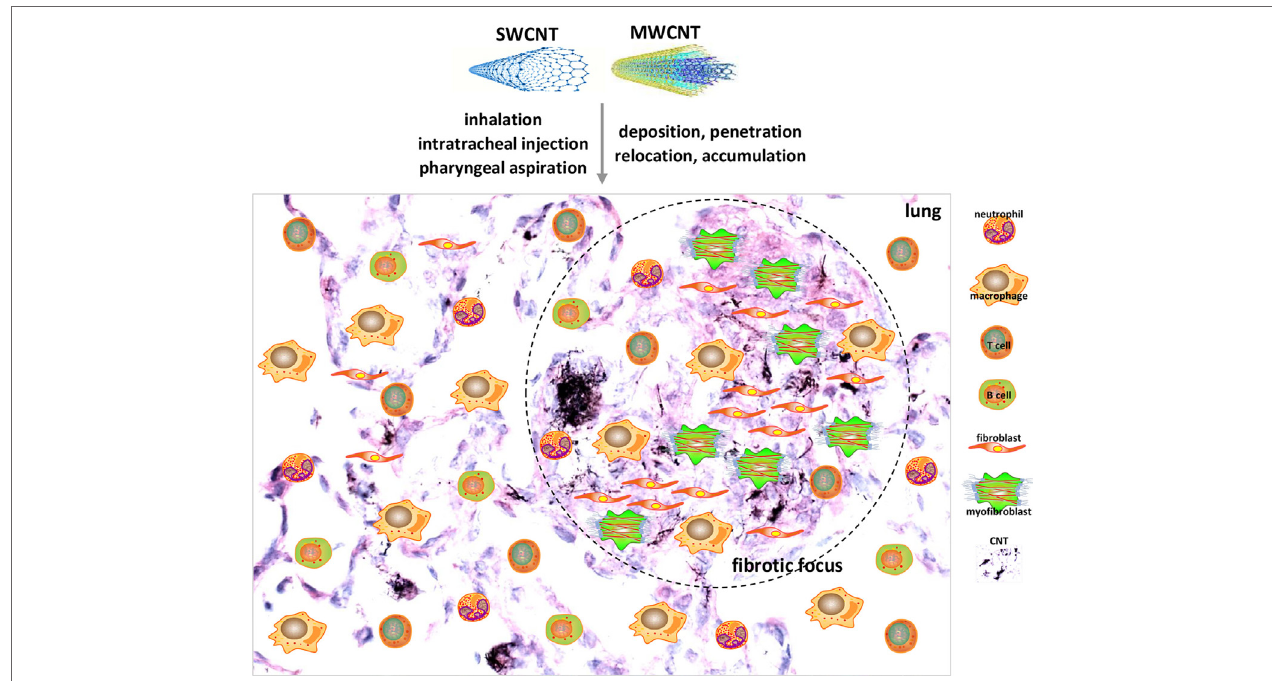
FiGURe 1 | Acute lung inflammation and fibrosis induced by carbon nanotubes (CNTs). CNTs are nano-scaled, respirable fibers with propensity to deposit, penetrate, relocate, and accumulate in lung tissues. Pulmonary exposure to CNTs induces acute-phase responses including a vigorous inflammatory response represented by immune cell recruitment, infiltration, and activation, and a fibrotic response demonstrated by fibroblastic cell accumulation, extracellular matrix deposition, and fibrotic focus formation. Shown are examples of cell types implicated in acute-phase responses as insets on a histopathological image of mouse lungs on day 7 post-exposure to MWCNTs to illustrate acute inflammation and fibrosis. These acute-phase lesions will transit to chronic-phase responses with the occurrence of interstitial fibrosis, epithelioid granuloma formation, and mild inflammation that persist for at least 1 year